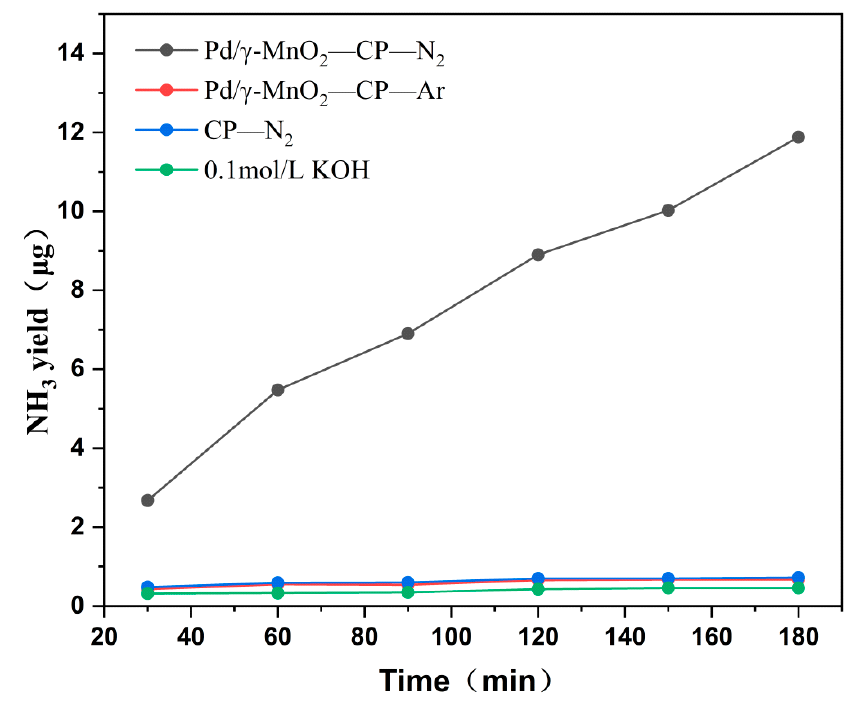
Figure 13. The curve of ammonia yield and time under four different conditions.